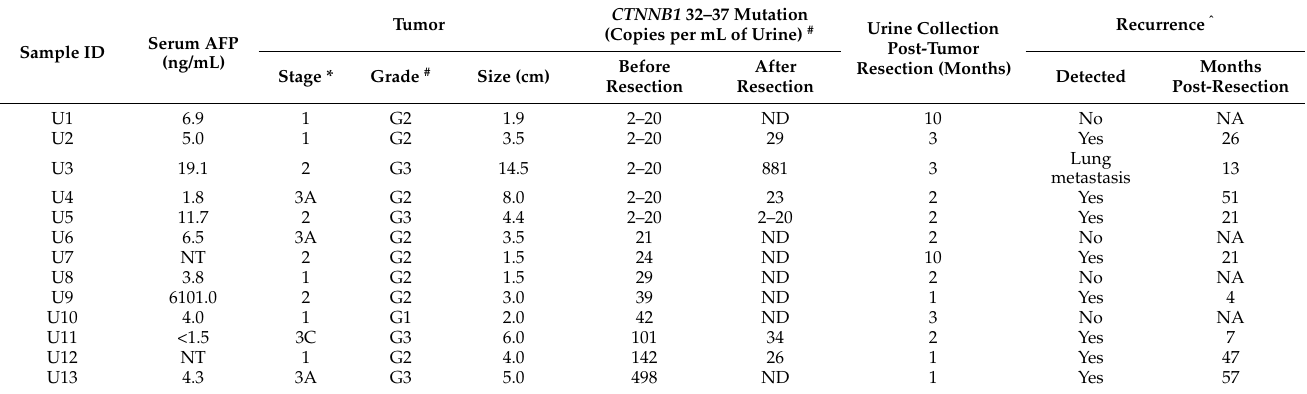
Table 3. Detection of CTNNB1 hotspot mutations in urine of HCC patients before and after tumor resection.